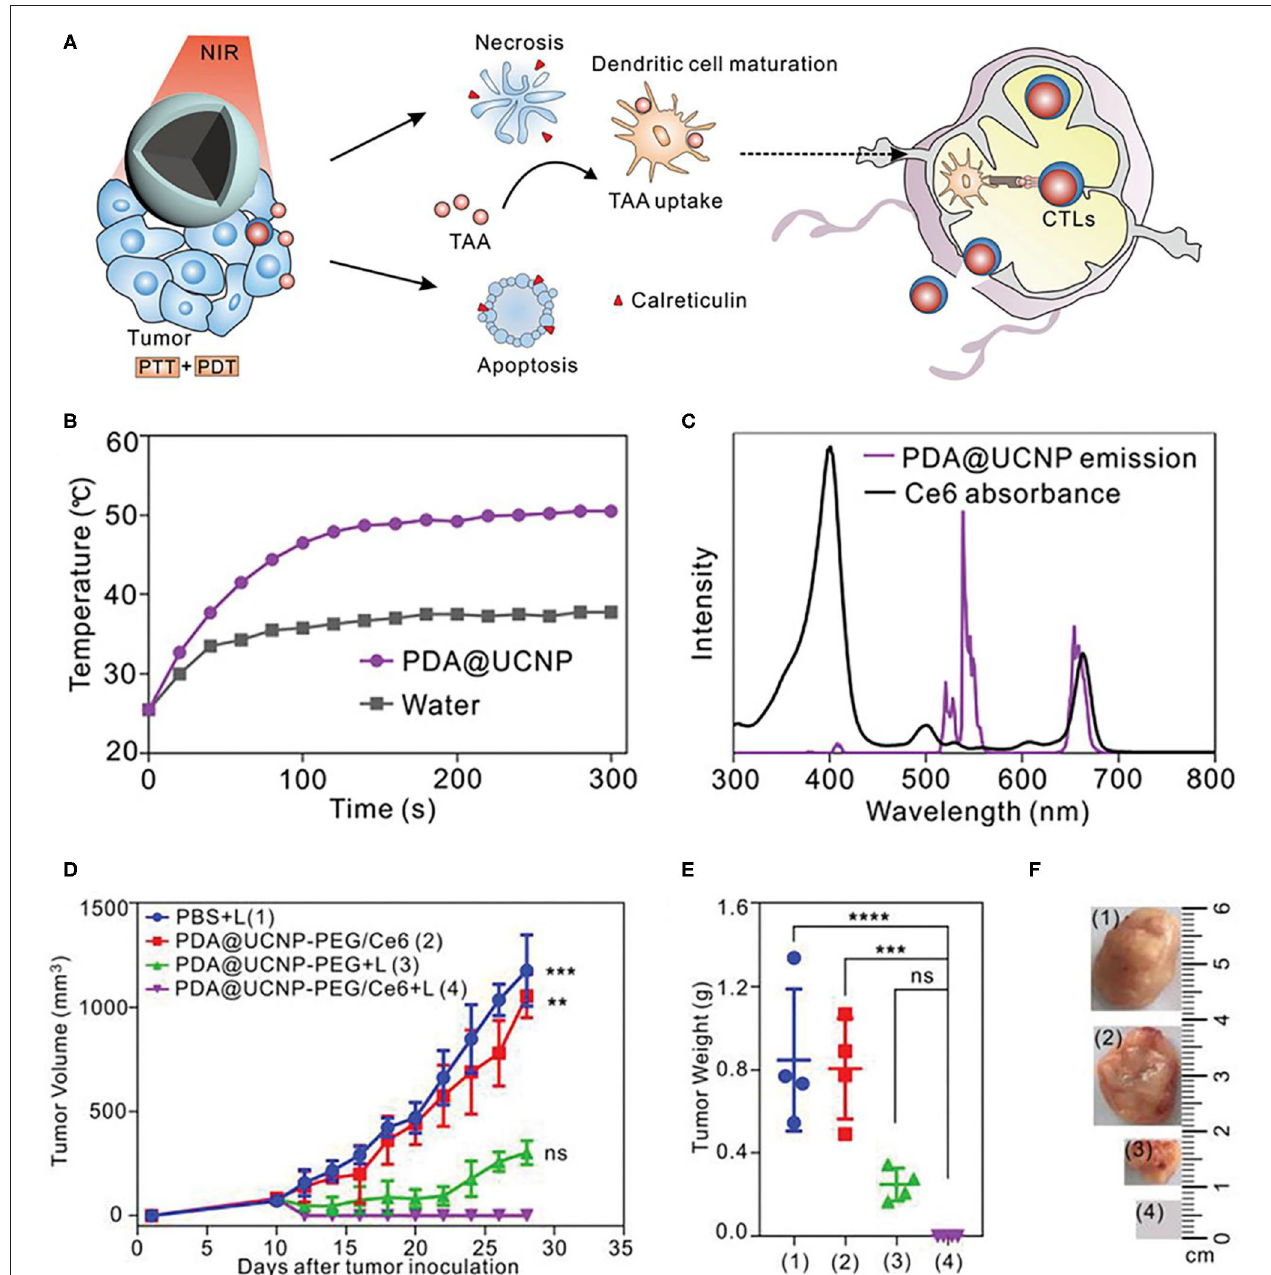
FIGURE 7 | (A) Scheme of synergistic phototherapy for augmentation of antitumor immunity. Upon laser irradiation, designed nanoparticles can ablate the primary tumor through synergistic phototherapy, and the released TAA tend to trigger the antitumor immunity which contributes to the inhibition of tumor metastasis and relapse. (B) Temperature profiles of pure water and aqueous dispersions of PDA@UCNP nanoparticles (2mg mL − 1 ) as a function of irradiation time (0–5min). (C) The spectrum profiles of Ce6 absorption and PDA@UCNP emission excited with a 980nm laser. (D) Tumor growth curve of 4T1 tumor-bearing mice with various treatments. Weight (E) and representative images (F) of the tumor from each group after euthanizing the animal on day 28. Copyright 2019, Wiley-VCH (Yan et al., 2019). ** P < 0.01, *** P < 0.001, **** P < 0.0001 and ns: not significant ( P > 0.05).